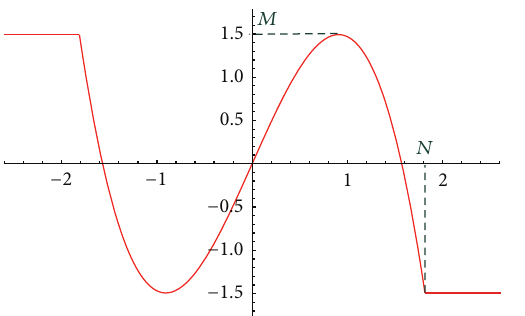
Figure 2: Graph of function 𝑓(𝑥) = (𝜋 2 /4)𝑥 − 𝑥 3 . Figure 3: Graph of truncated function